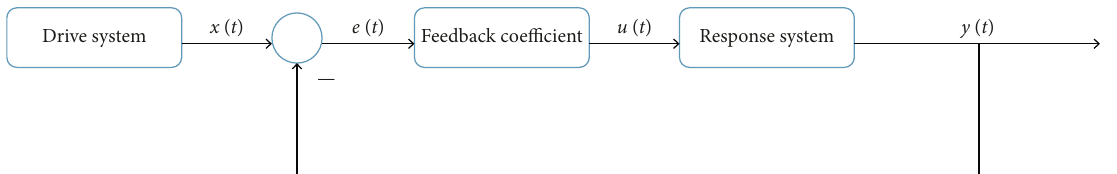
Figure 1: Structure diagram of state feedback control